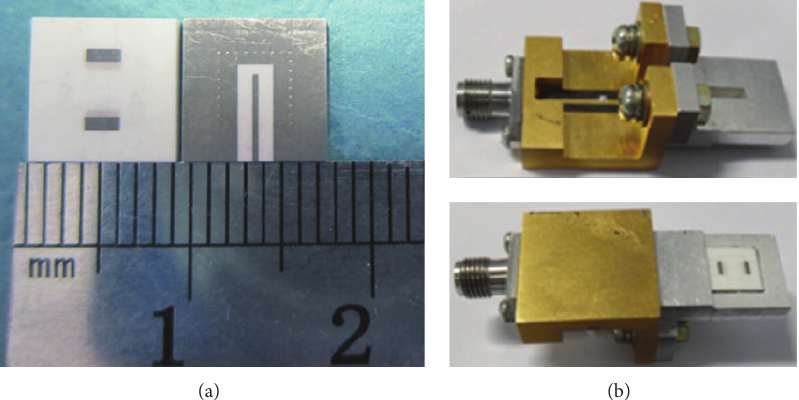
Figure 2: Top view and bottom view of the antenna and the fixture. (a) The fabricated antenna. (b) The fixture for